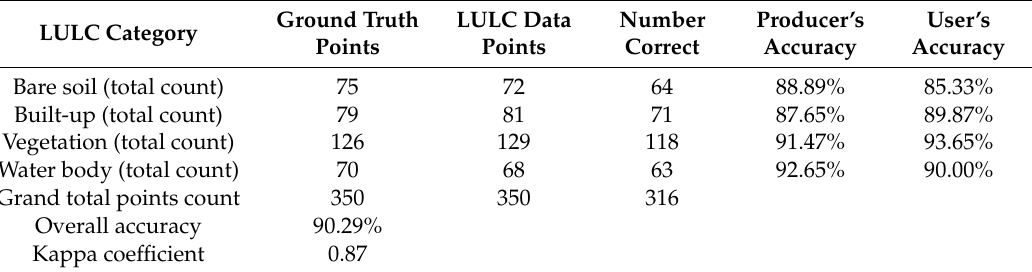
Table 5. The error matrix for the classified image of